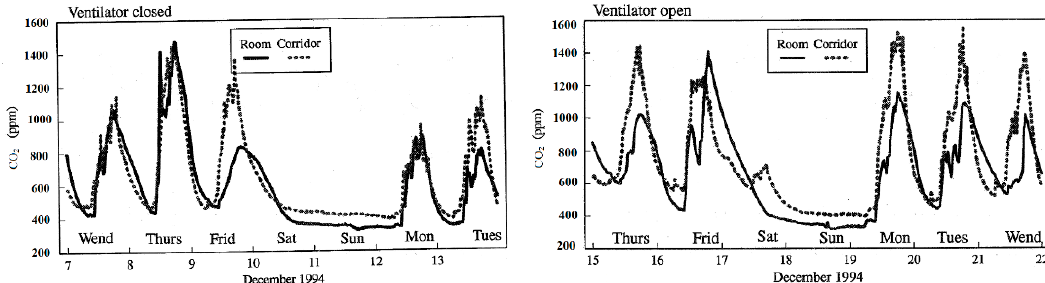
Figure 22. CO 2 distribution—Office A with ventilators closed ( left ); Office B with ventilators open ( right ) [41].